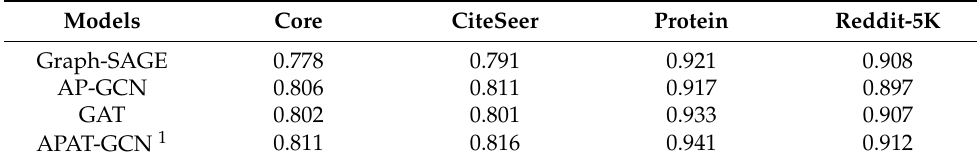
Table 2. Prediction results for the four data sets (micro-averaged F1).